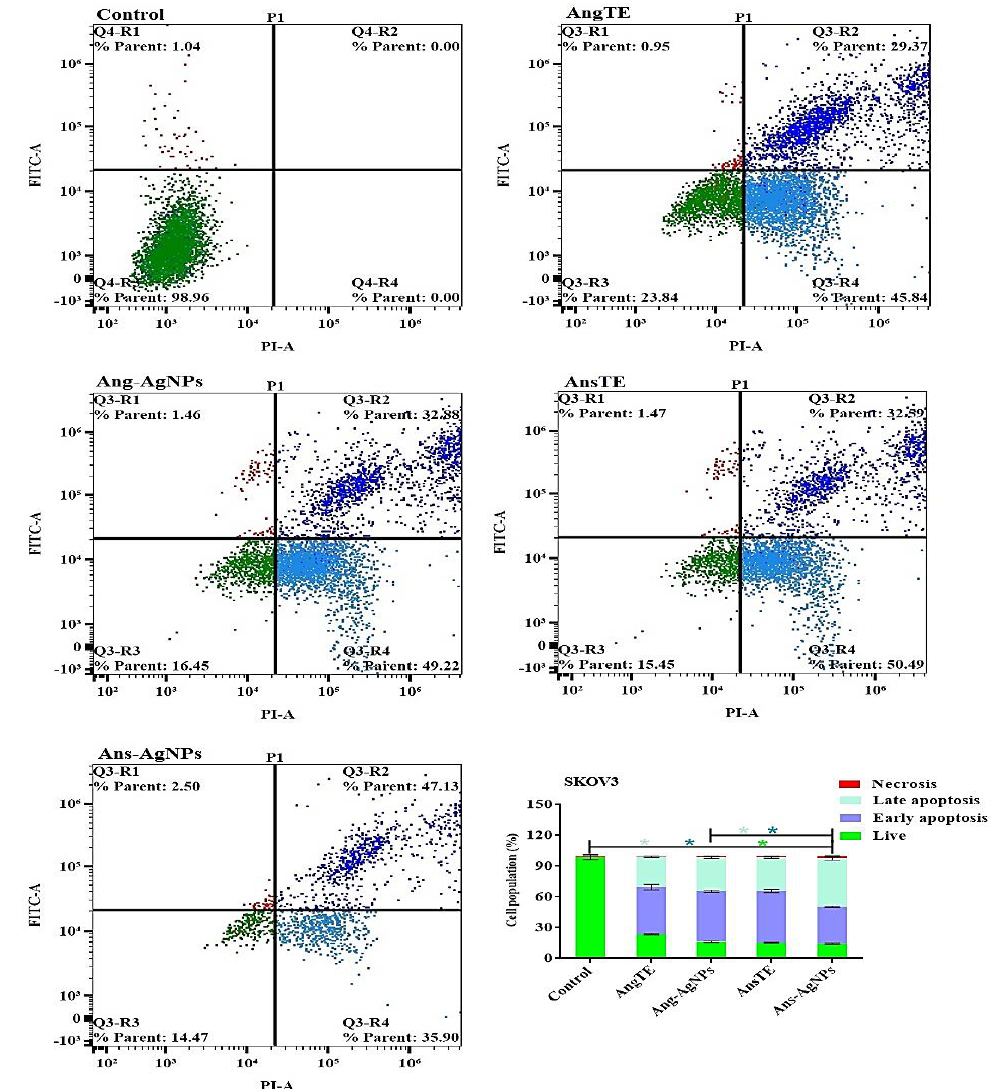
Figure 13. Apoptosis/necrosis assessment of the extracts, AngTE, AnsTE, and their nanoparticles, Ang-AgNPs, and Ans-AgNPs, respectively, against SKOV3 subjected to previous treatment for 48 h, and apoptosis/necrosis quantified using flow cytometry. Data are presented as the mean ± SD; n = 3; One-way ANOVA was used to test for statistical difference (* p < 0.05).